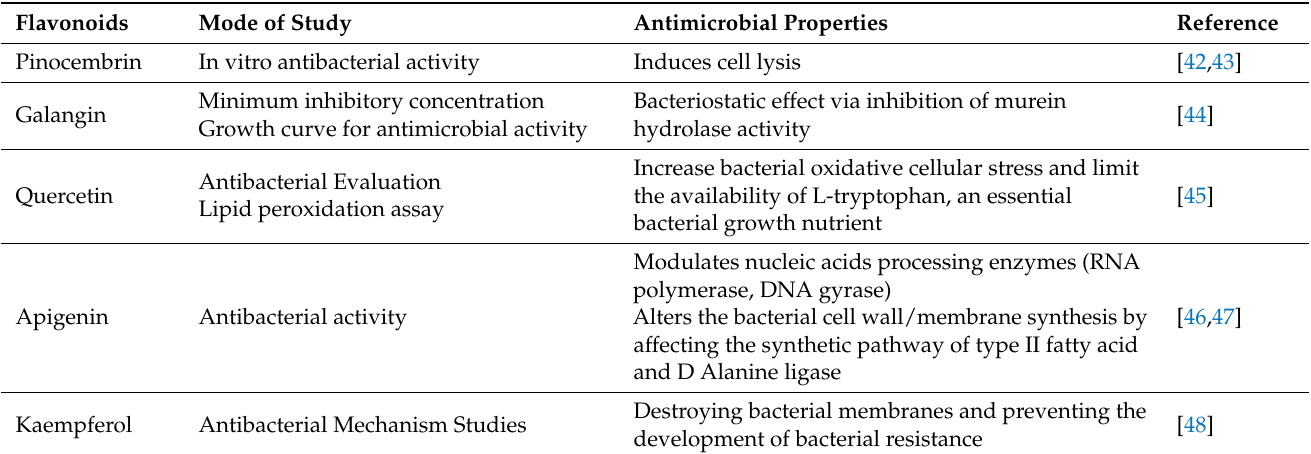
Table 3. Common flavonoids found in honey and their antibacterial properties.